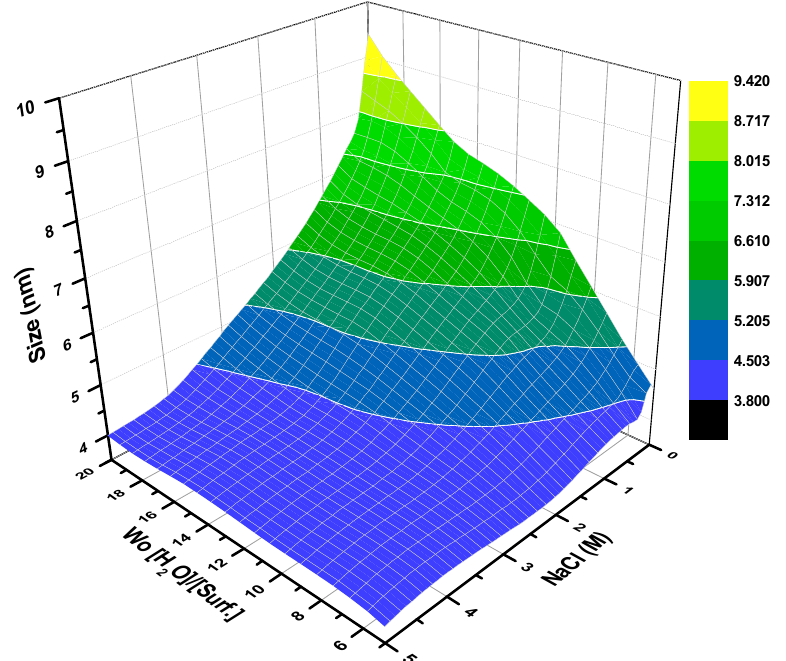
Figure 2. Behavior of average size distributions of AOT/Water/Isooctane reverse micellar systems from variation in aqueous content (Wo) and